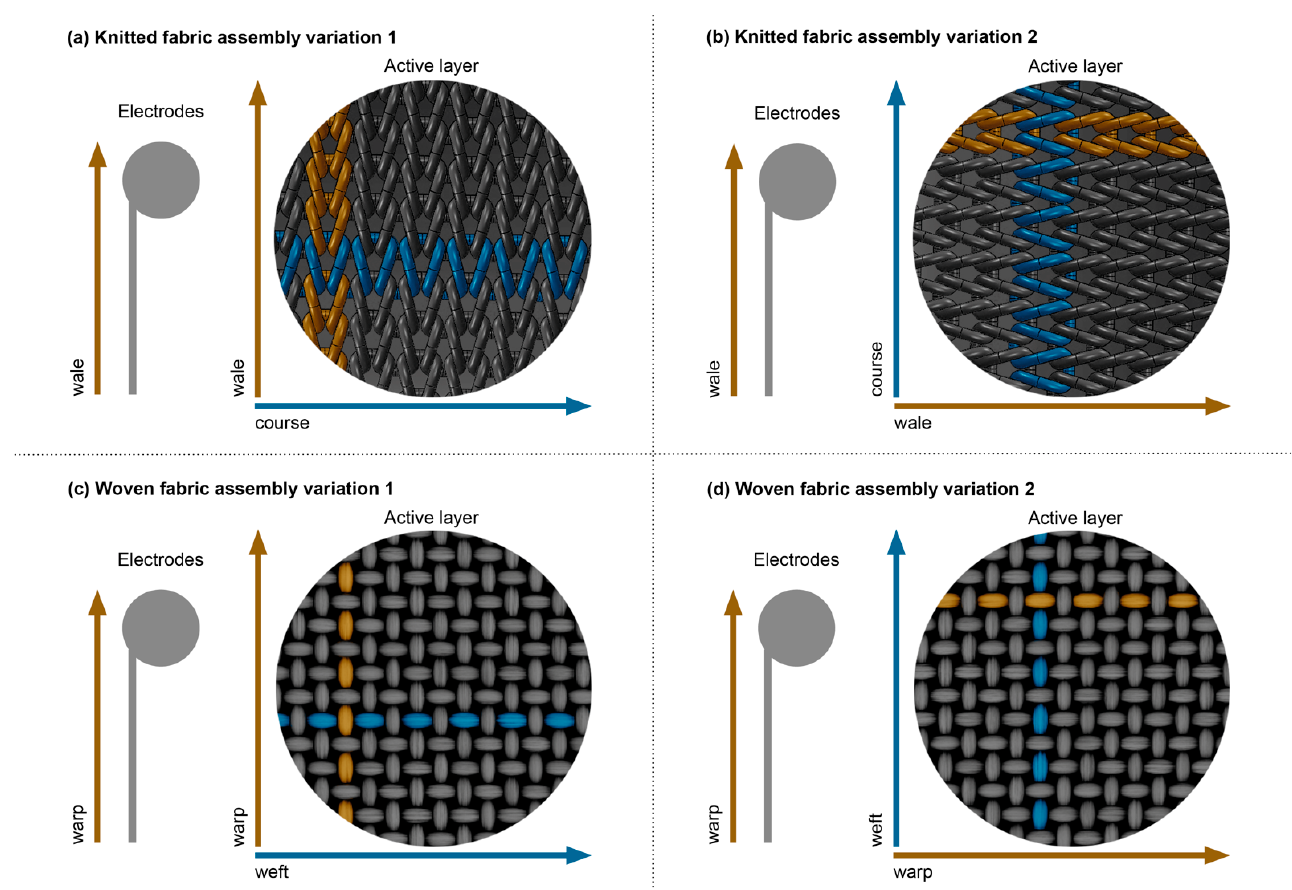
Figure 2. Variations of active layer assembly: ( a , c ) the electrodes and the active layer are positioned in the same direction, both in the longitudinal position of the substrates; ( b , d ) the electrodes and the active layer are positioned in different directions, with the electrodes in the longitudinal position of the textile substrates and the active layer parallel to the substrates’ transversal position. The copper colour represents the walewise direction in knitted fabrics and the warpwise direction in woven fabrics. The blue colour represents the coursewise direction in knitted fabric and the weftwise direction in woven fabrics.